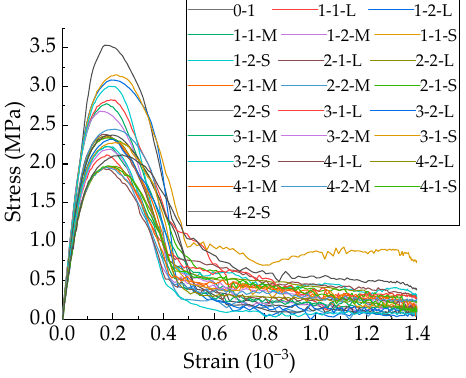
Figure 15. The stress − strain curves. Table 4. Mechanical properties of concrete specimens.